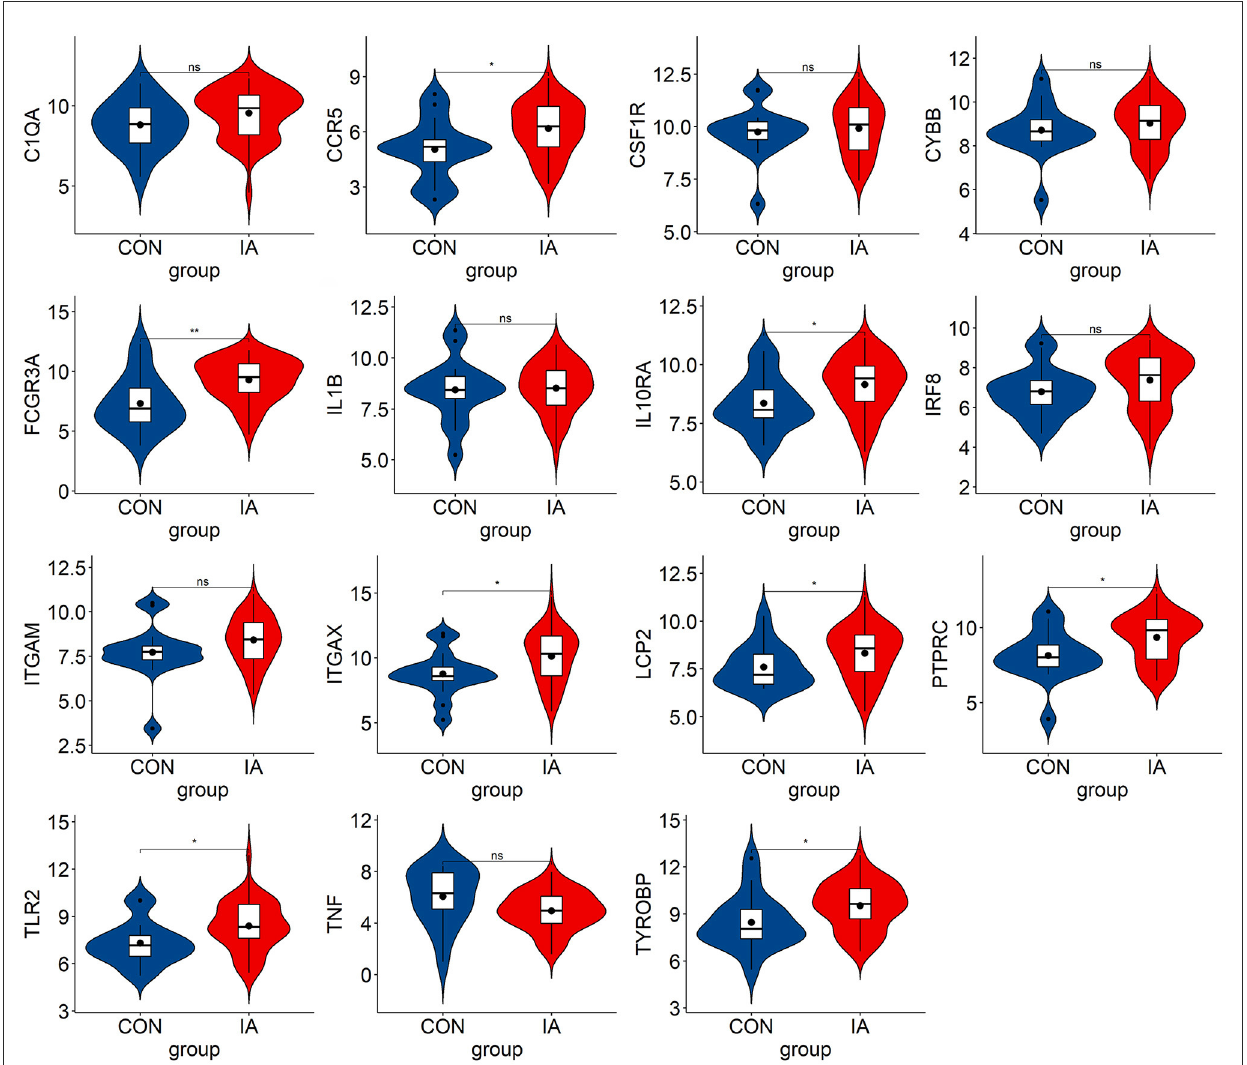
FIGURE7 The hub genes expression level in GSE122897. The mean t -test is used for the comparison of the two datasets. Statistical significance was determined when the P -value < 0.05. IA, intracranial aneurysm samples; CON, control intracranial cortical arterials. * p < 0.05; ** p < 0.01. ns, p >